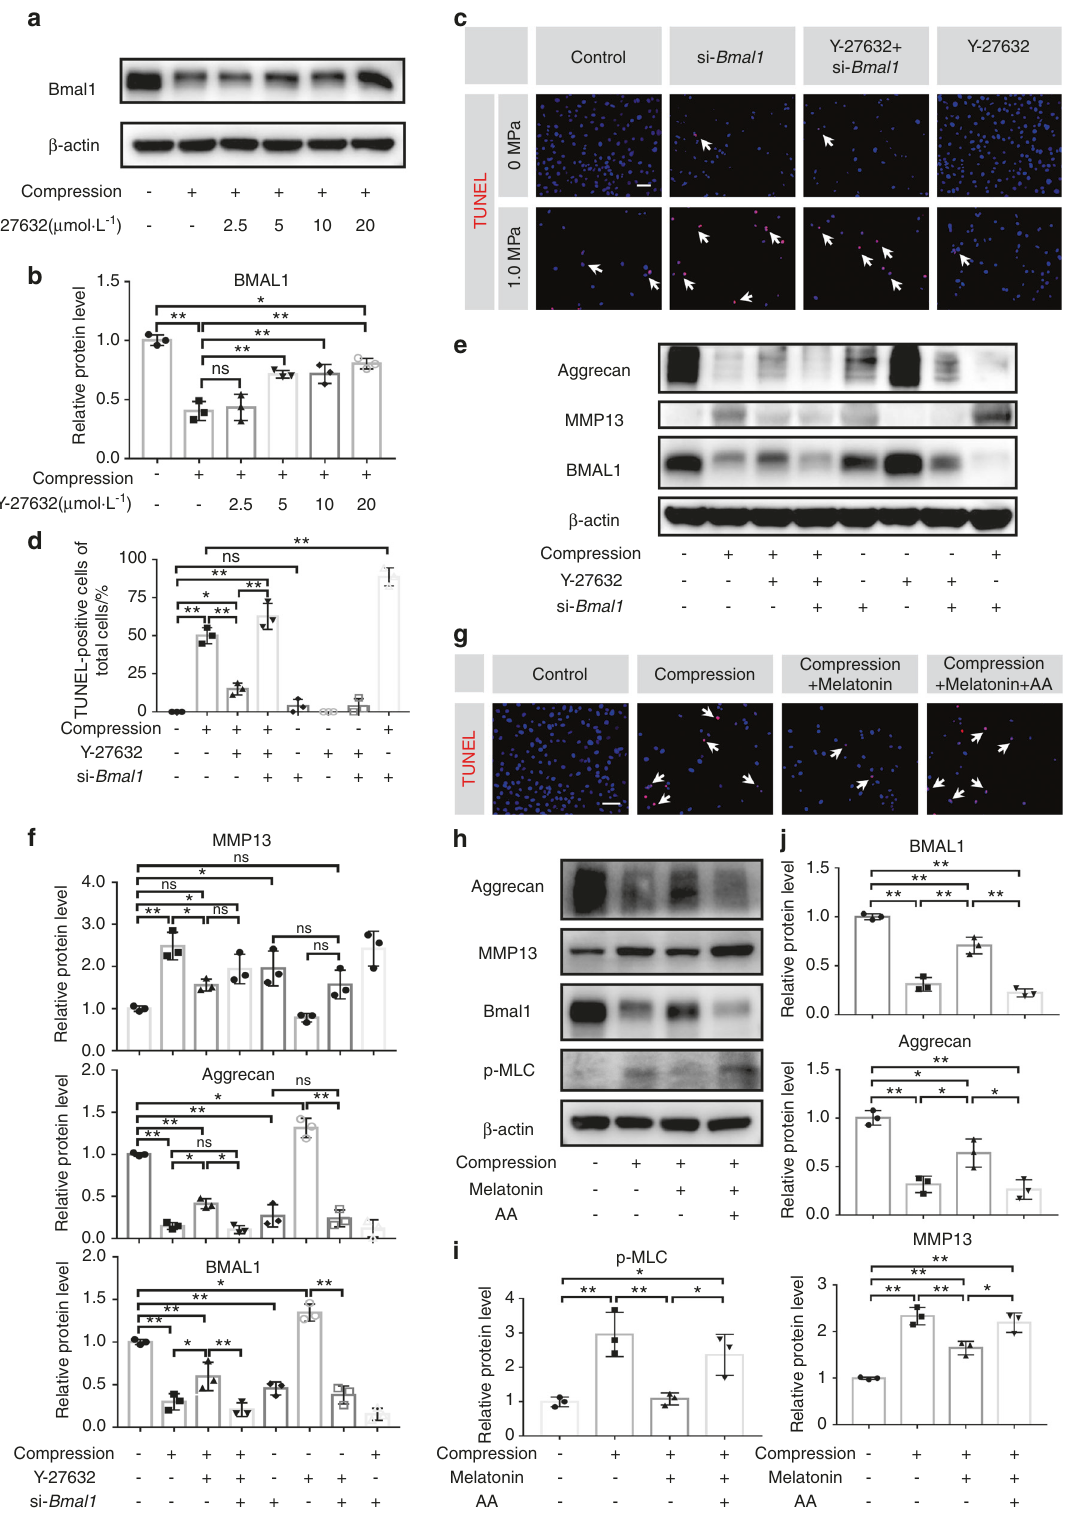
Fig. 5 Upregulation of BMAL1 expression by inhibiting the RhoA/ROCK pathway ameliorates compression-induced apoptosis of NP cells and degradation of ECM in NP tissues. a, b The protein levels of BMAL1 in NP cells treated with compression and different doses of Y-27632. c, d The apoptosis level of NP cells detected by TUNEL staining. Scale bar: 50 μ m. White arrows: TUNEL-positive cells. e, f The protein expression of Aggrecan, MMP13, and BMAL1 detected by western blots in NP cells. g The apoptosis level of NP cells detected by TUNEL staining. Scale bar: 50 μ m. White arrows: TUNEL-positive cells. h – j The protein expression of Aggrecan, MMP13, BMAL1, and p-MLC detected by western blots in NP cells. The data in the fi gures represent the mean ± S.D. ns not signi fi cant, ** P < 0.01, * P < 0.05, n = 3. Differences among multiple groups were analyzed by one-way